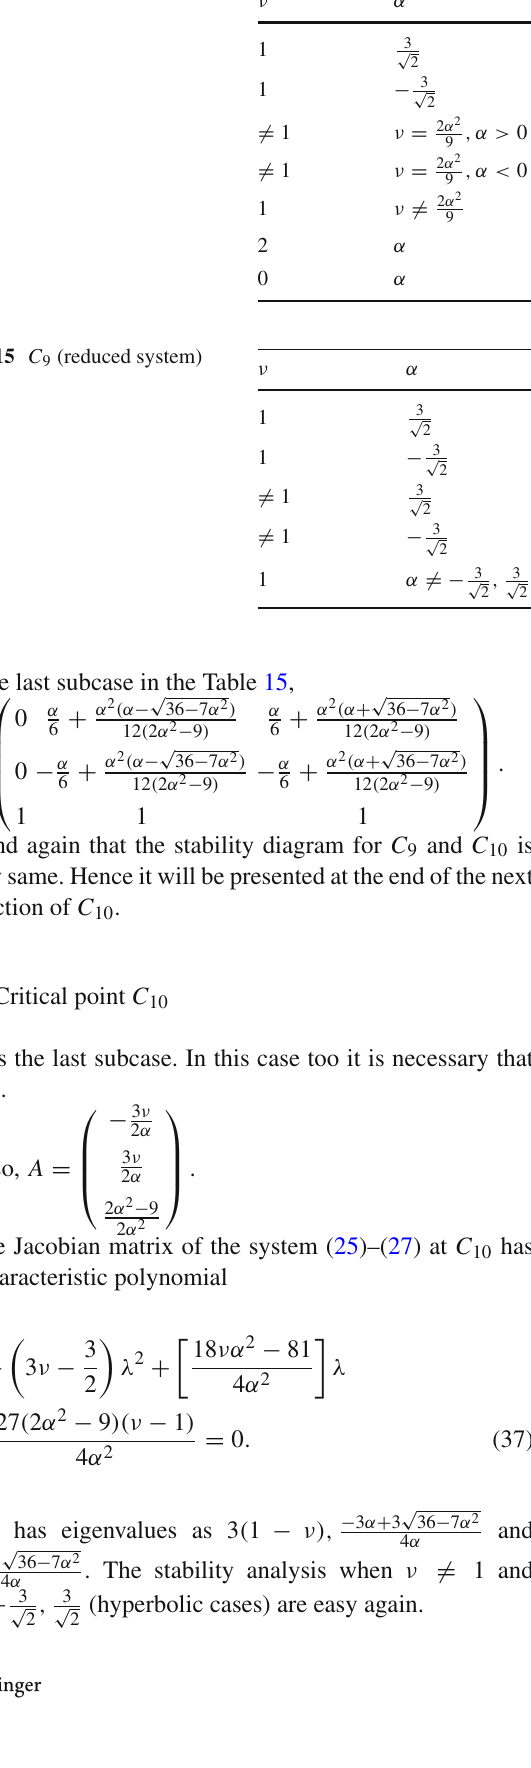
Table 14 C 8 (reduced system)